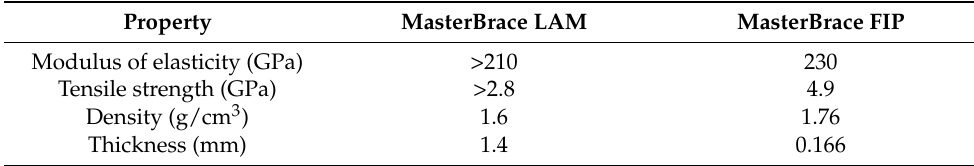
Table 4. CFRP technical